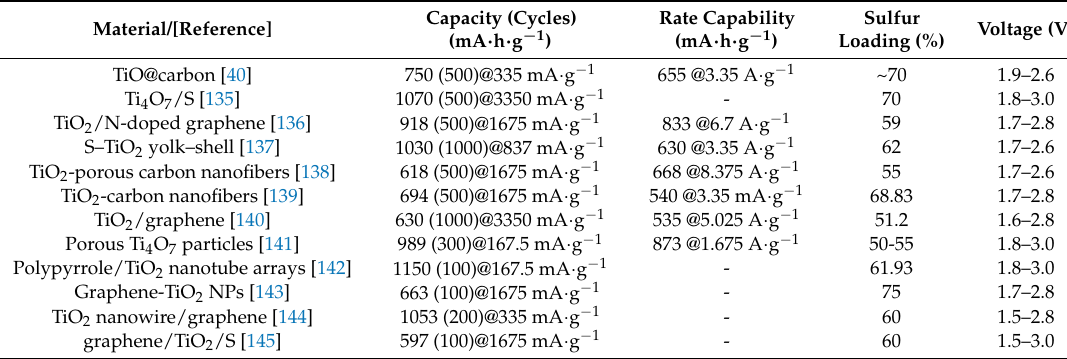
Table 2. Comparison of Li–S batteries performance based on typical titanium oxides electrode (the voltage is versus Li +